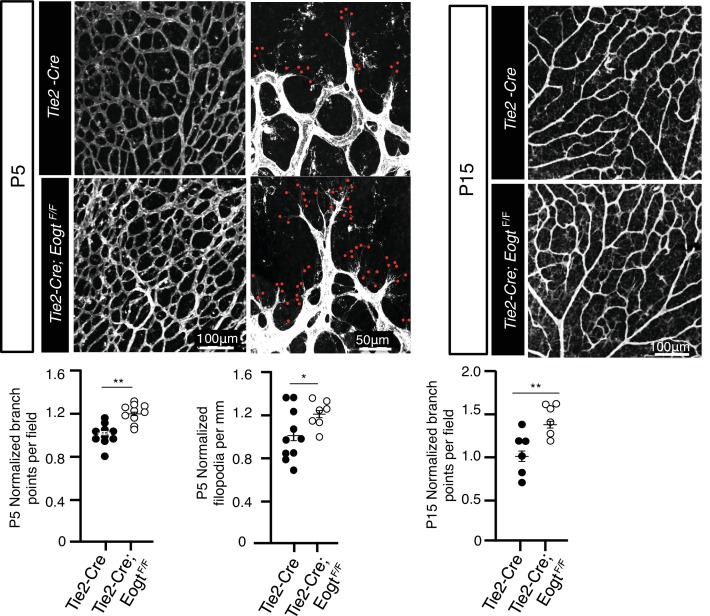
Images of control Tek-Cre and Tek-Cre EogtF/F retinas stained with isolectin B4 (IB4) and quantification of branch points in P5 (N = 6 mice) and P15 (N = 3 mice) retinas and numbers of filopodia per mm vascular front in P5 retinas (N = 6 mice).Data were normalized from mean ± standard error; p values were calculated by unpaired two-tailed Student’s t-test. *p≤0.05; **p≤0.01.